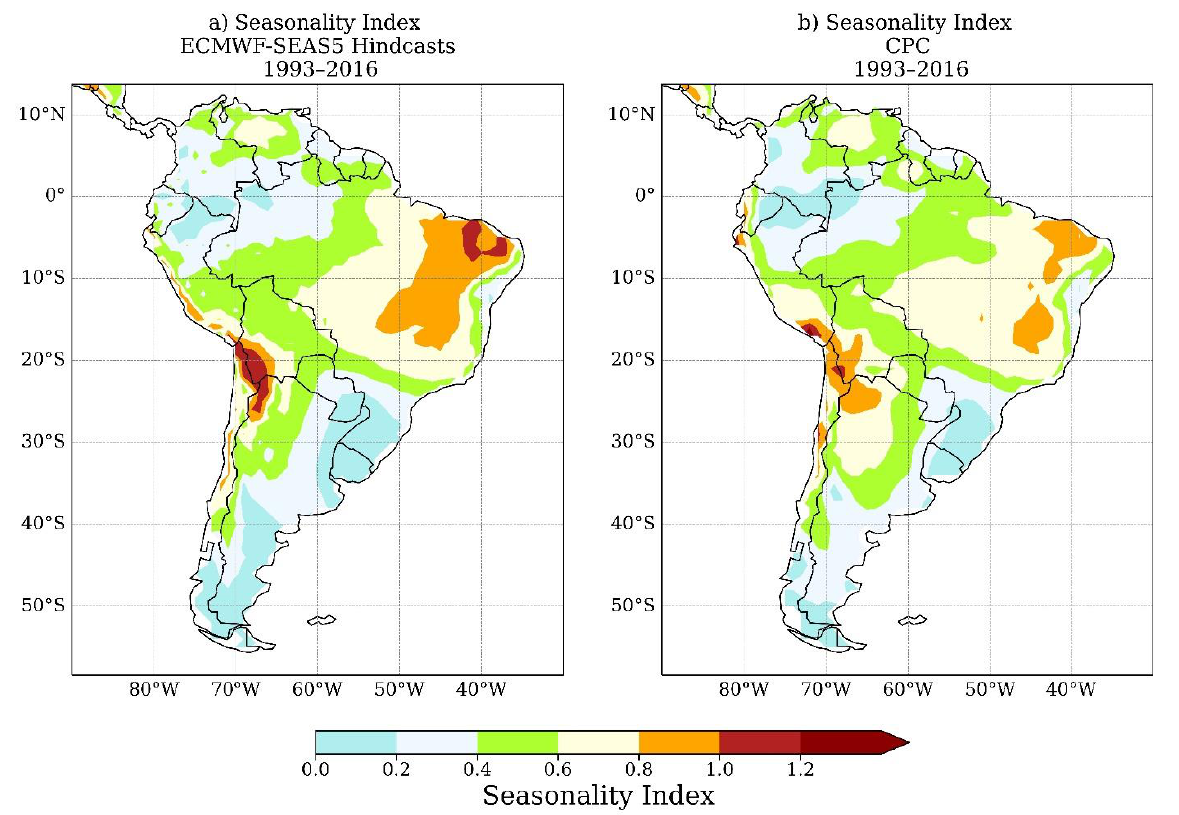
Figure 10. Seasonality Index (SI) derived from the ( a ) ECMWF-SEAS5 hindcasts and ( b ) CPC over 1993–2016 for South America.